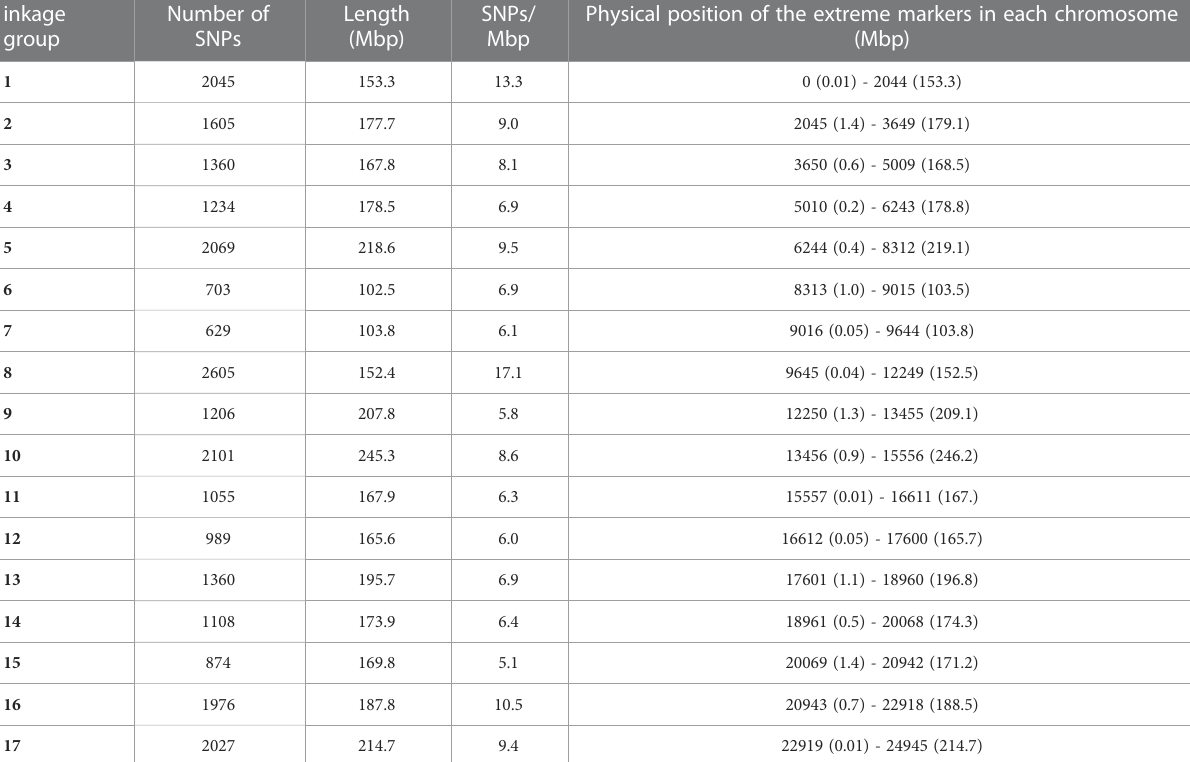
TABLE 4 SNPs distribution across all the chromosomes with the position (bp) of the fi rst and the last molecular marker per linkage group. inkage Number of Length SNPs/ Physical position of the extreme markers in each chromosome group SNPs (Mbp) Mbp